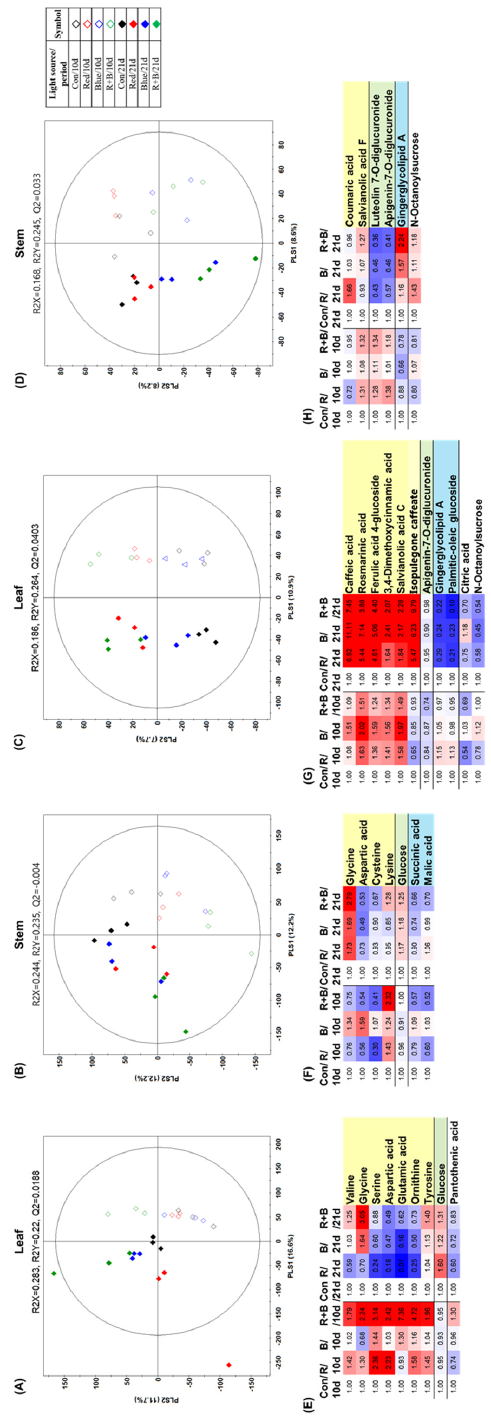
Figure 5. PLS-DA score plots derived from GC–TOF-MS datasets ( A , B ) and UHPLC–LTQ-MS / MS datasets ( C , D ) under di ff erent supplemental LED lighting conditions in Perilla frutescens . Significantly altered metabolites (VIP > 1.0 and p -value < 0.05) are represented by fold change from GC–TOF-MS datasets for leaves ( E ) and stems ( F ) and UHPLC–LTQ-MS / MS datasets for leaves ( G ) and stems ( H ). Con: control; R: red; B: blue; R + B: red–blue